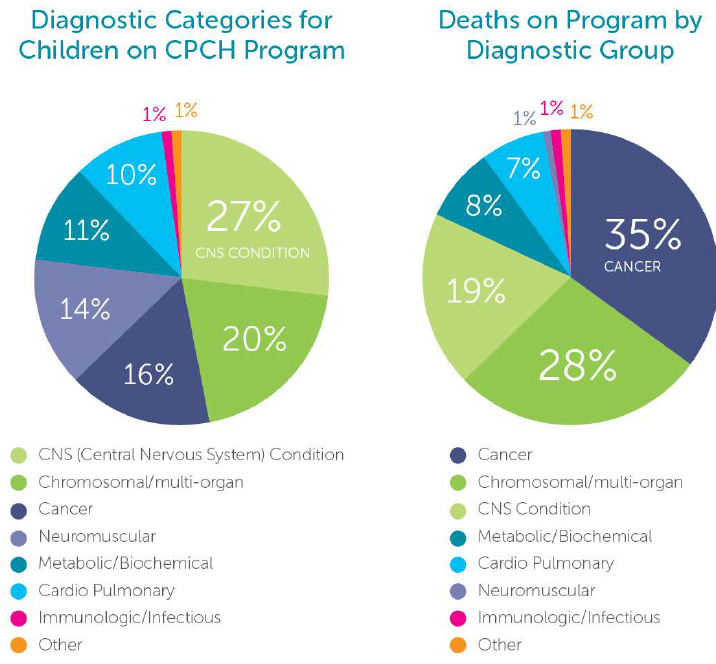
Figure 1. Children on Program and Deaths on Program Canuck Place Children’s Hospice.